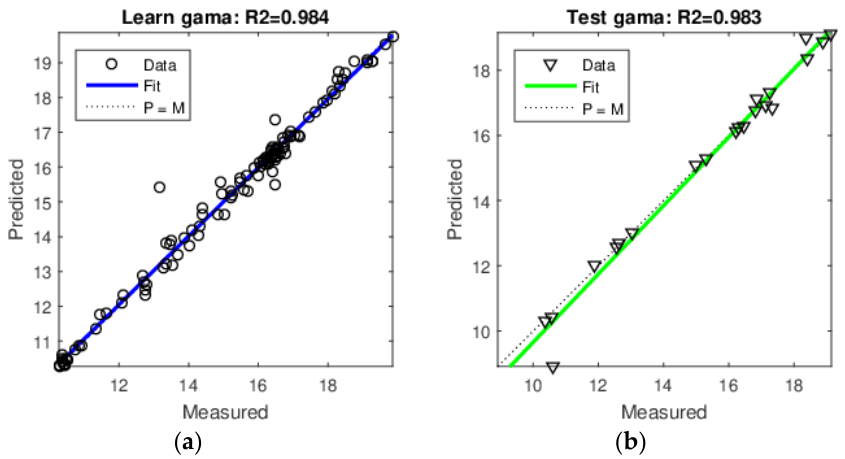
Figure 16. Regression of the ANN prediction of soil unit weight ( LOIT, w ): ( a ) learn data and ( b ) test data.